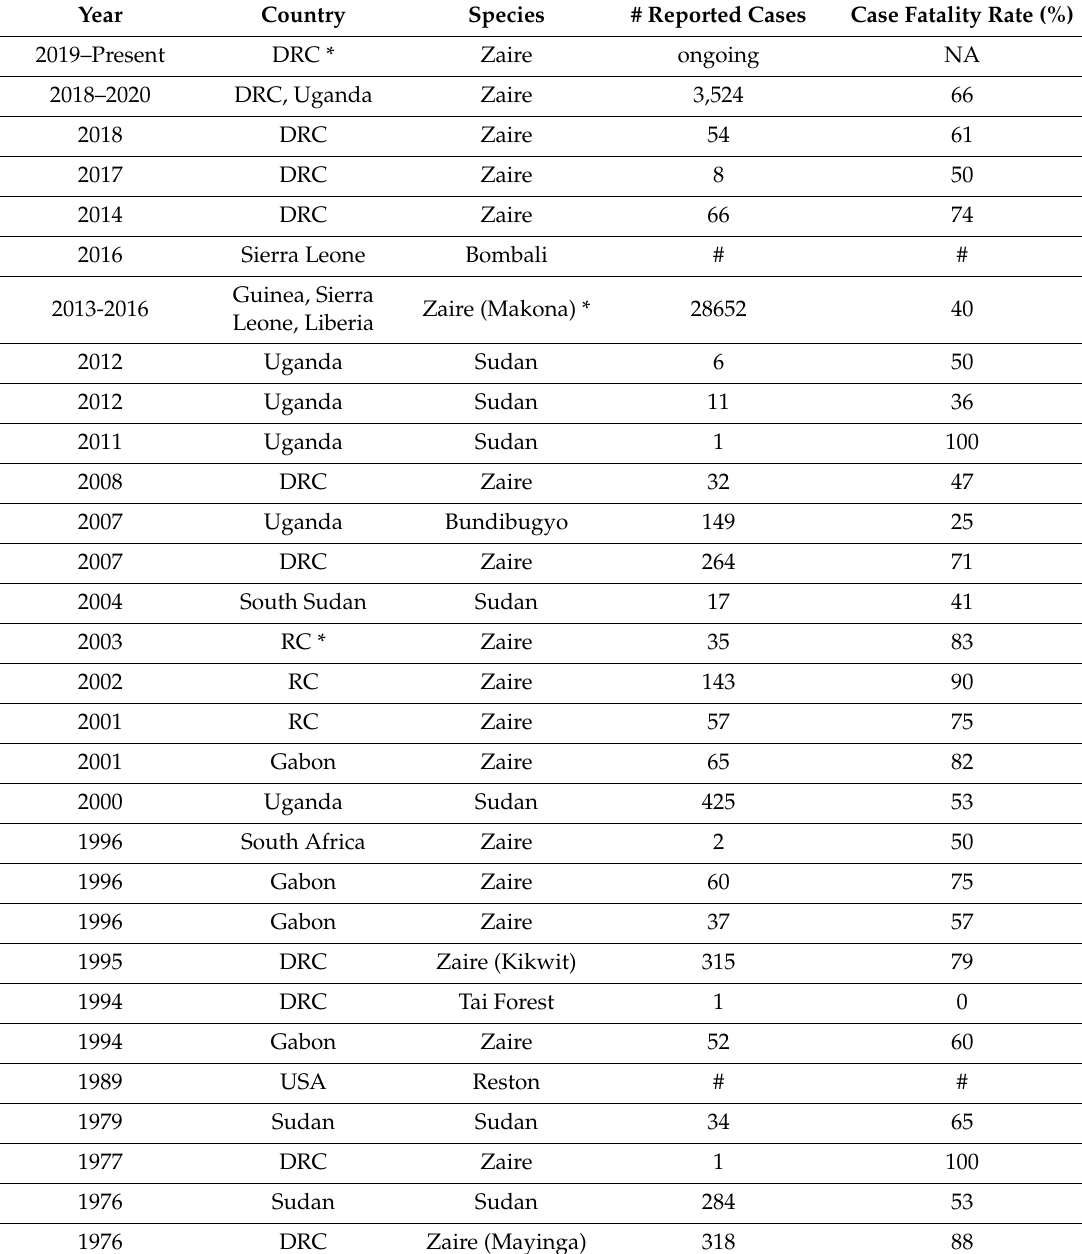
Table 1. Outbreaks and Identification of Ebola